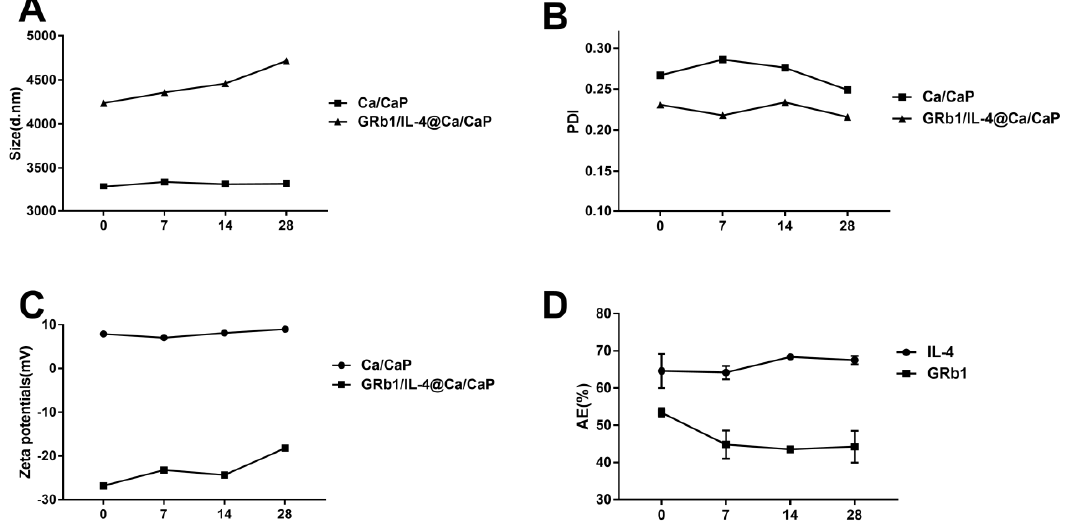
Figure 2. Stability of nanoparticles suspensions at 4 °C. The particle dimension ( A ), PDI value ( B ), zeta potential ( C ), as well as GRb1-AE (%) and IL-4-AE (%) ( D ) of the CCS/CaP and GRb1/IL- 4@CS/CaP nanoparticles suspensions were assessed over a 4-week period.